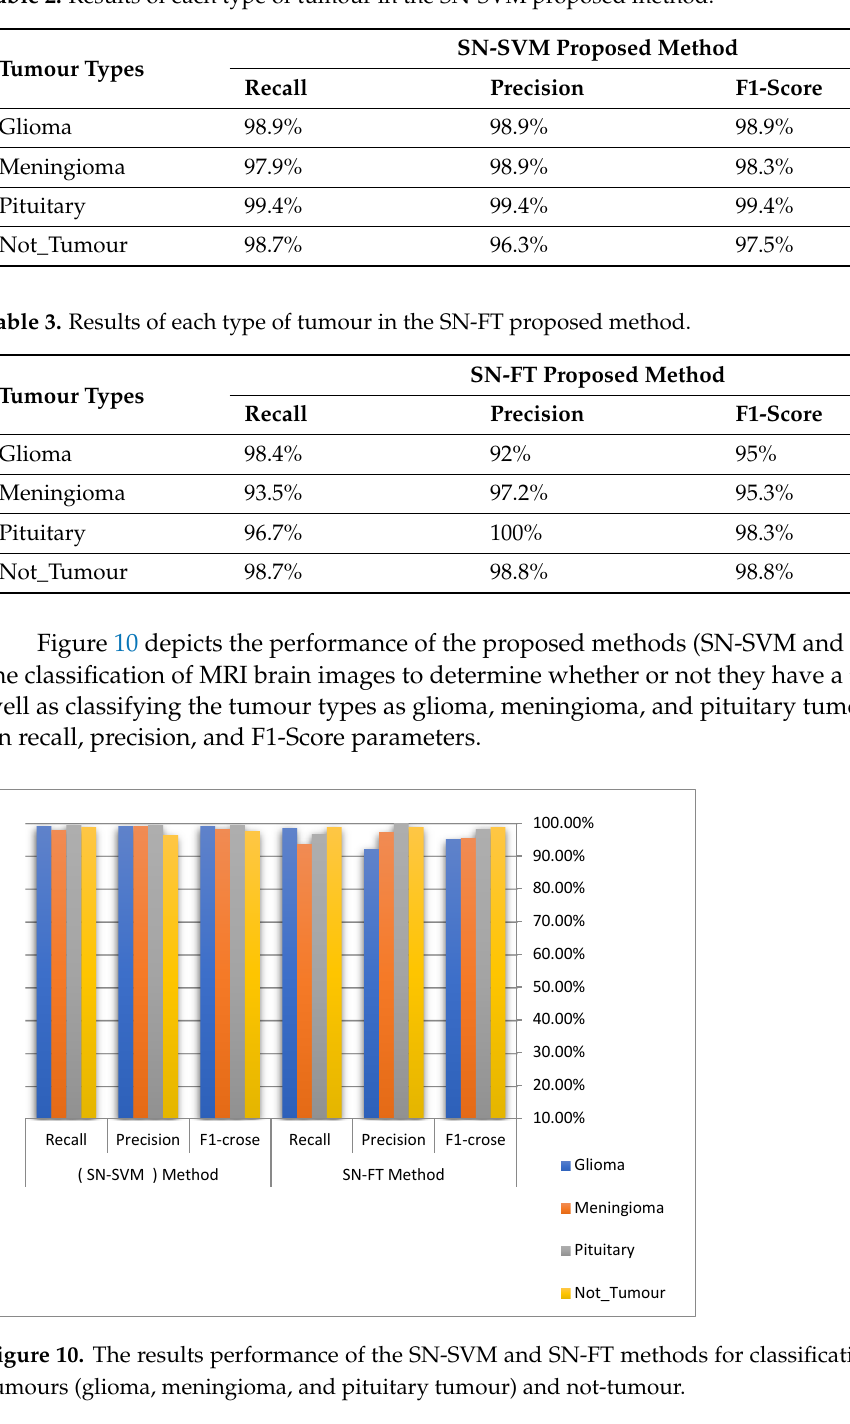
Table 2. Results of each type of tumour in the SN-SVM proposed method.